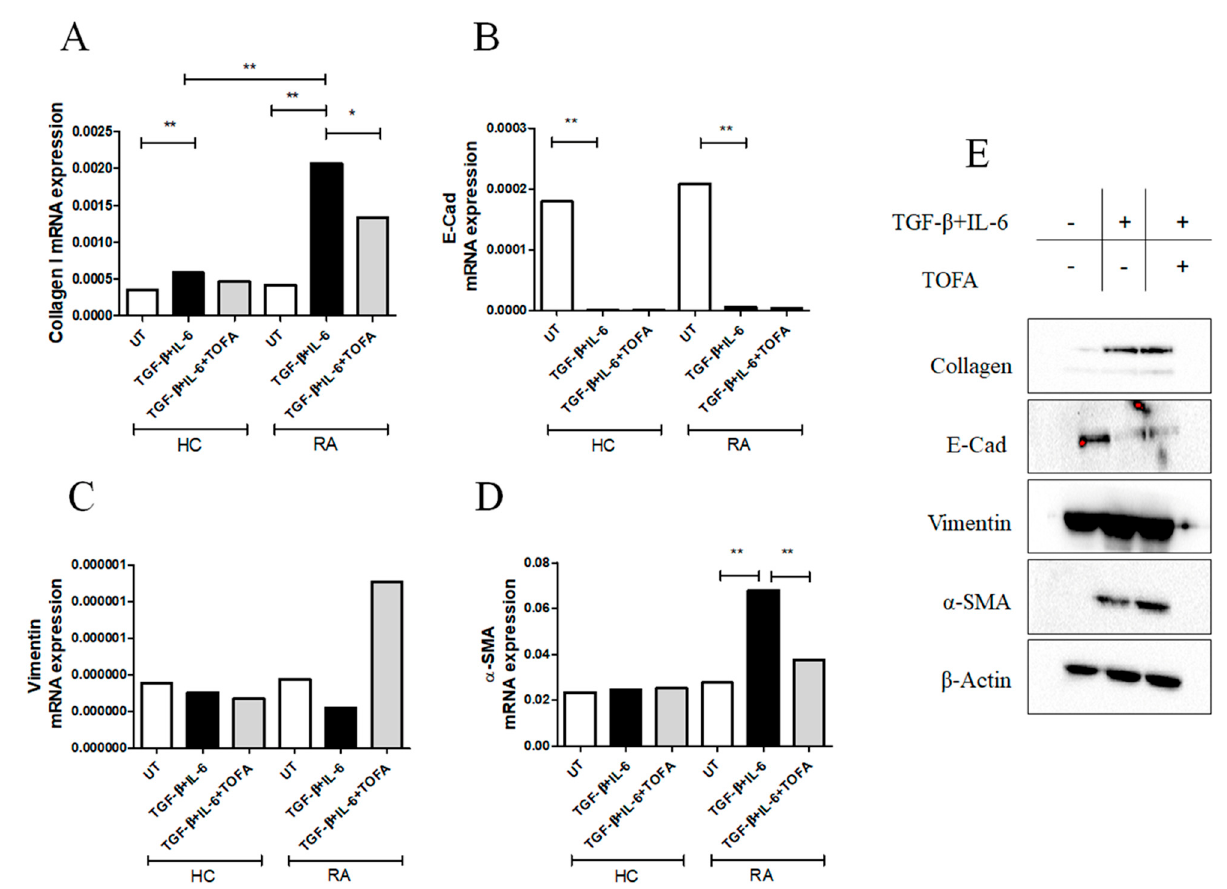
Figure 2. The effects of TGF- β and IL-6 with or without tofacitinib (TOFA) stimulations on RA-FLSs. ( A ) qRT-PCR of collagen I (TGF- β + IL-6 stimulation: collagen I mRNA expression in HCFLSs treated with TGF- β + IL-6 0.00058 (0.00047–0.00072) vs. collagen I mRNA expression in untreated (UT)-HC-FLSs 0.00035 (0.00024–0.00041), p = 0.002; collagen I mRNA expression in RA-FLSs treated with TGF- β + IL-6 0.0020 (0.0018–0.0035) vs. collagen I mRNA expression in RA-HC-FLSs 0.00041 (0.00027–0.0013), p = 0.002), (TOFA stimulation: collagen I mRNA expression in RA-FLSs treated with TGF- β + IL-6 0.0020 (0.0018–0.0035) vs. collagen I mRNA expression in RA-FLSs treated with TGF- β + IL-6 and TOFA 0.0013 (0.00029–0.0020), p = 0.01). ( B ) E-Cad (TGF- β + IL-6 stimulation: E-Cad mRNA